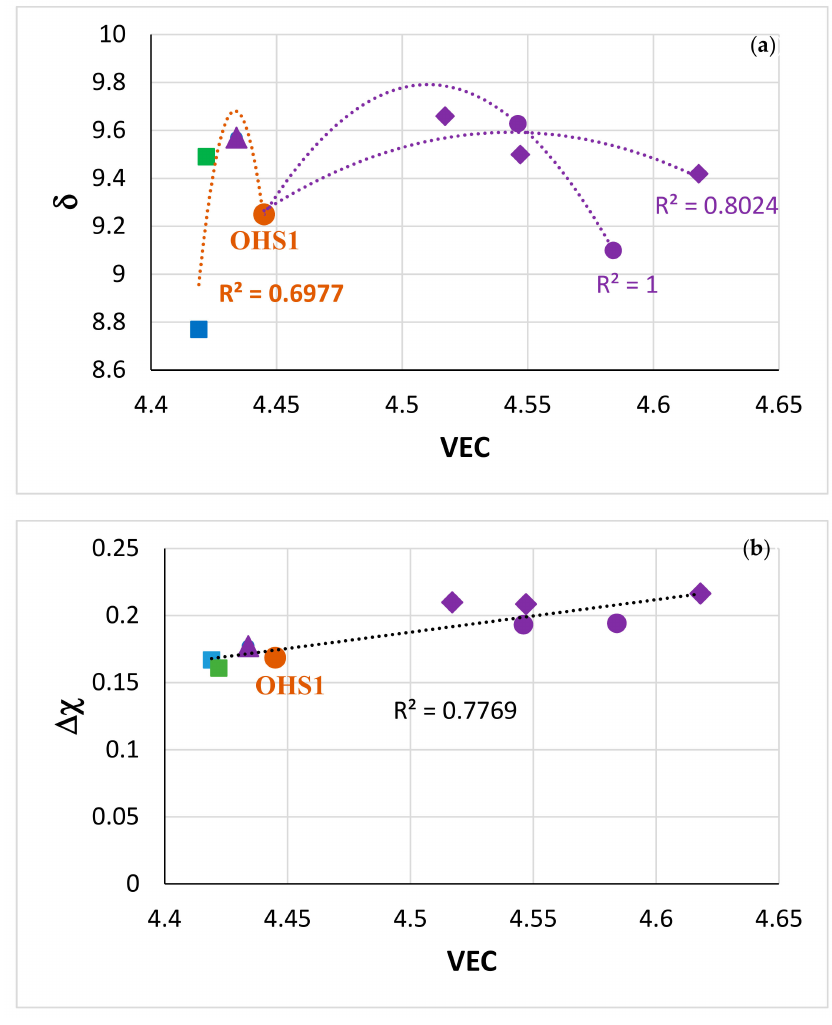
Figure 14. ( a ) δ versus VEC map and ( b ) ∆ χ versus VEC map of Nb-silicide / RCCA alloys, data for the alloys OHS1 [45], JZ3, JZ3 + [47], JG6 [56], EZ8 [58], ZF9 [59], for nominal compositions see Abbreviations. Diamonds for alloys JZ4, JZ5, NT1 [78], purple circles for alloys JZ3, JZ3 + , triangle JG6, green square EZ8, blue square ZF9, brown circle